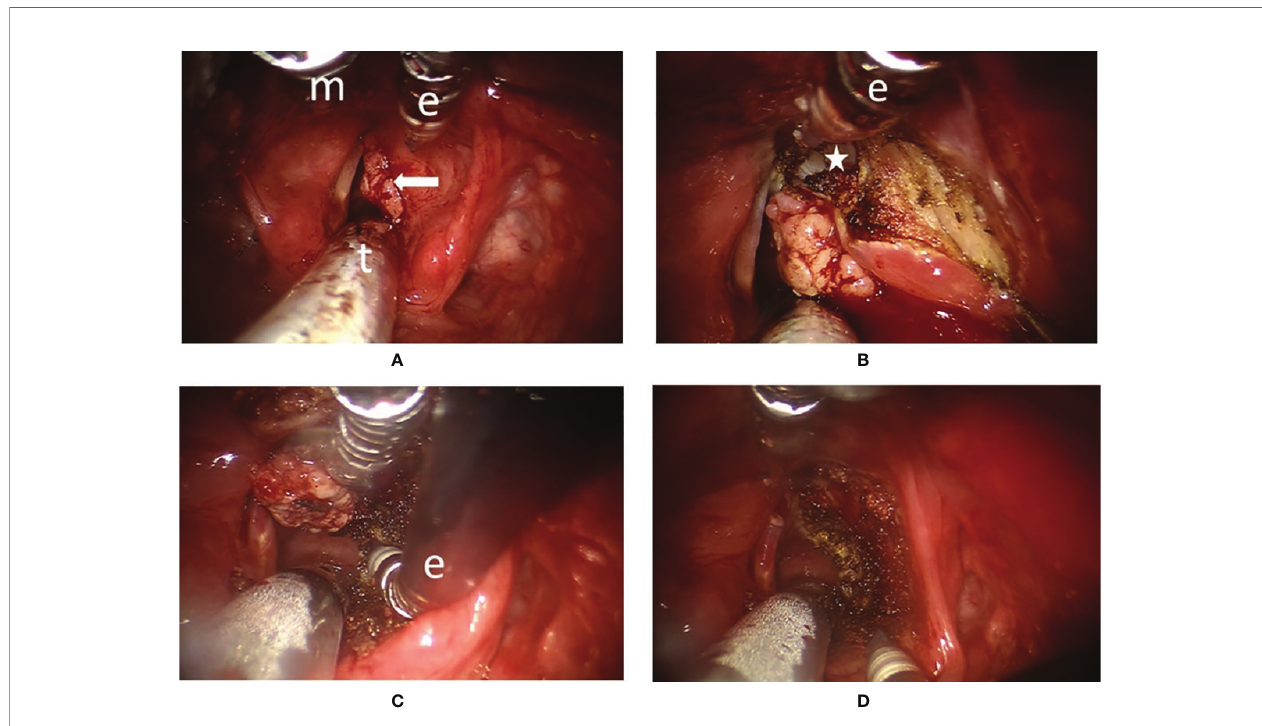
FIGURE 2 | Surgical endoscopic view of transoral robotic surgery (TORS) for a type Va+c cordectomy in patient #13 (A) The panoramic view of a right vocal fold cancer with anterior commissure involvement (arrow). General anesthesia was delivered via the oral endotracheal tube (t). Maryland dissector (m) and monopolar electrocautery (e) were used to perform the dissection. (B) The spatula tip of the monopolar electrocautery (e) could be used to peel the perichondrium from the thyroid cartilage inner lamina (star) and to peel the Broyles ’ ligament from the anterior commissure during superior part dissection. (C) The tip of the monopolar electrocautery (e) was angled anteriorly to cut along the upper border of the cricoid cartilage indicating the bene fi t of endo-wristed function. (D) After en-bloc resection of the tumor, the wound was clean with minimal bleeding.